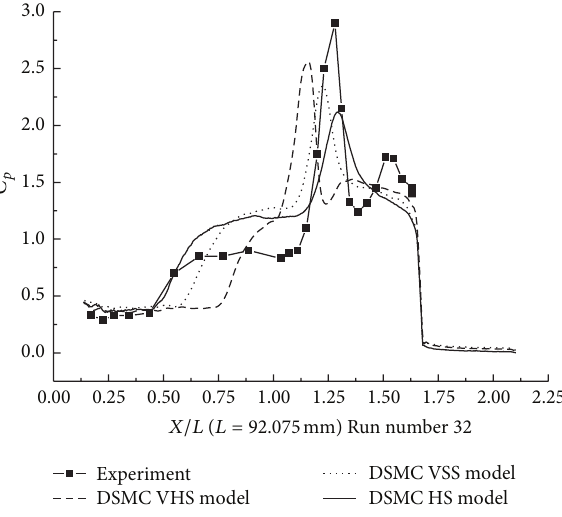
Figure 17: DSMC simulation of Run number 32 ( 𝐶 𝑃